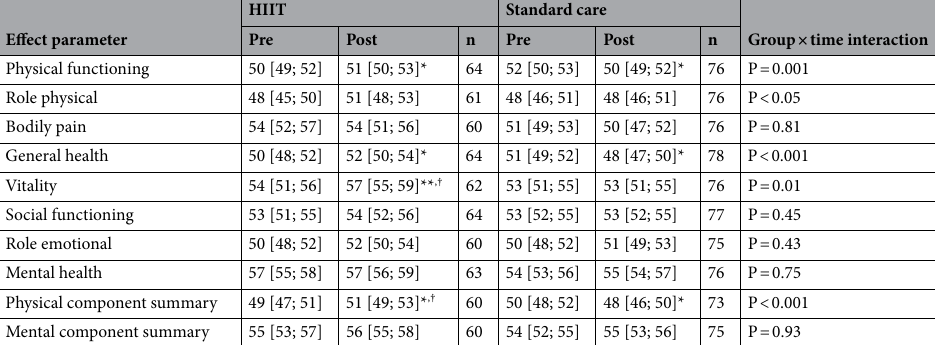
Table 3. Short form 36 health survey questionnaire, SF-36v2. Values are presented as a T-score with a mean (with 95% confidence intervals) from a linear mixed-model with group, time and group × time interaction as fixed factors. HIIT high-intensity interval training, Role-physical role limitations due to physical problems, Role-emotional role limitations due to emotional problems. If a significant effect of group × time interaction existed, the result of the post hoc analysis is indicated by *P < 0.05, **P < 0.001 compared to baseline and † P < 0.05 compared to standard